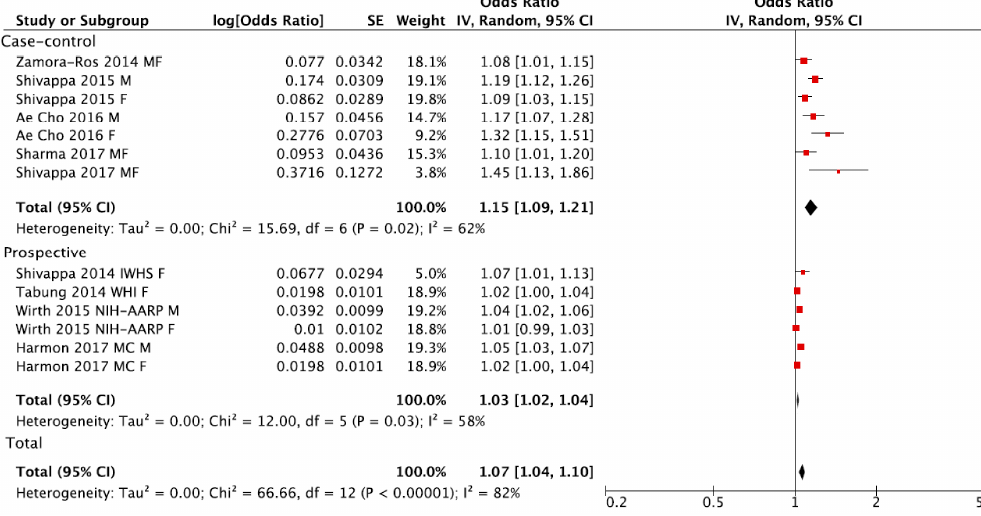
Figure 4. Forest plot of summary relative risks (RRs) of colorectal cancer for a one-point increase of Dietary Inflammatory Index (DII), for case-control, prospective and all studies.